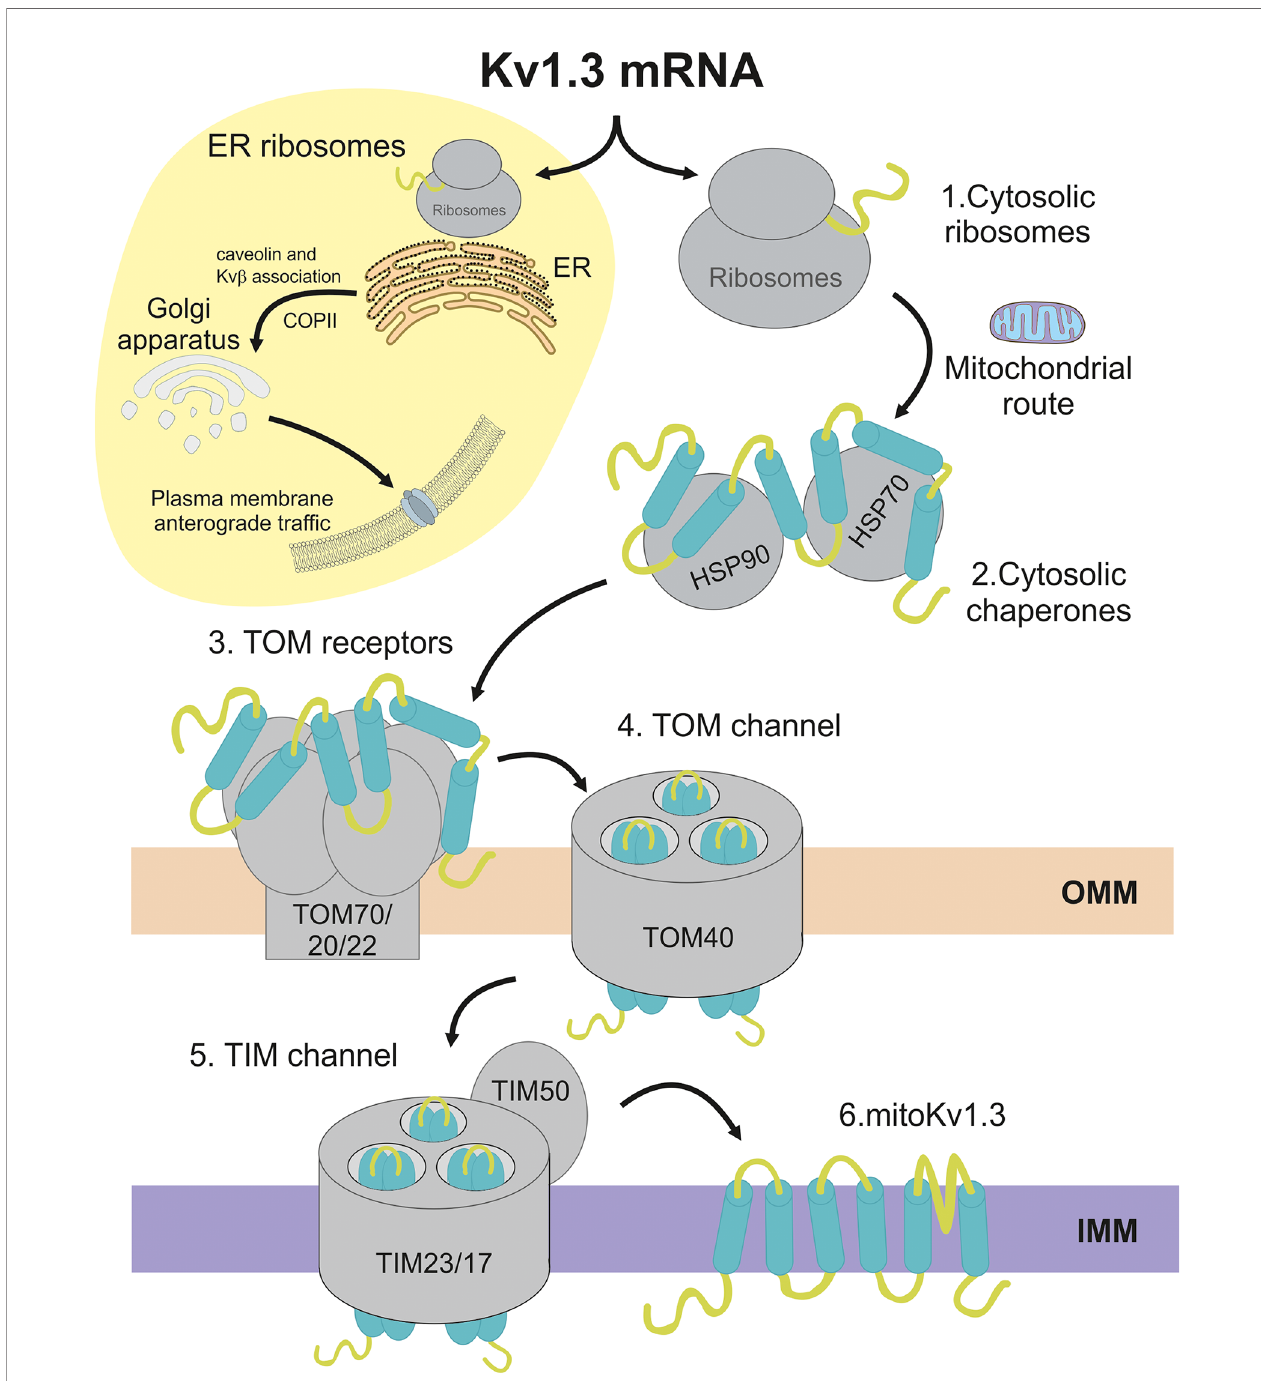
FIGURE 9 | Schematic representation of the mitochondrial import pathway for Kv1.3. The Kv1.3 channel is cotranslated by ER-linked and cytosolic ribosomes. ER ribosomes synthesize the plasma membrane Kv1.3, which interacts early with ancillary proteins, such as Kv b subunits and caveolin, and is routed to the cell surface via COPII-dependent anterograde traf fi cking. The yellow circle restrains anterograde traf fi cking to the plasma membrane. Alternatively, (1) the Kv1.3 mRNA, which is translated by cytosolic ribosomes, follows the mitochondrial route. (2) By interacting with channel hydrophobic domains, cytosolic chaperones and cochaperones provide Kv1.3 with a partially folded state competent for mitochondrial translocation. Sequential transmembrane domains from the N- to C-terminus cooperate to achieve the proper folded state. (3) TOM receptors recognize cytosolic Kv1.3. (4) The TOM40 channel at the OMM translocates Kv1.3 to the TIM complex at the IMM. Finally, (5) the TIM50 receptor facilitates Kv1.3 translocation through the TIM23/17 channel into the IMM (6) . Spatial and temporal mechanisms de fi ning Kv1.3 membrane topology and tetramerization at the IMM remain unknown.